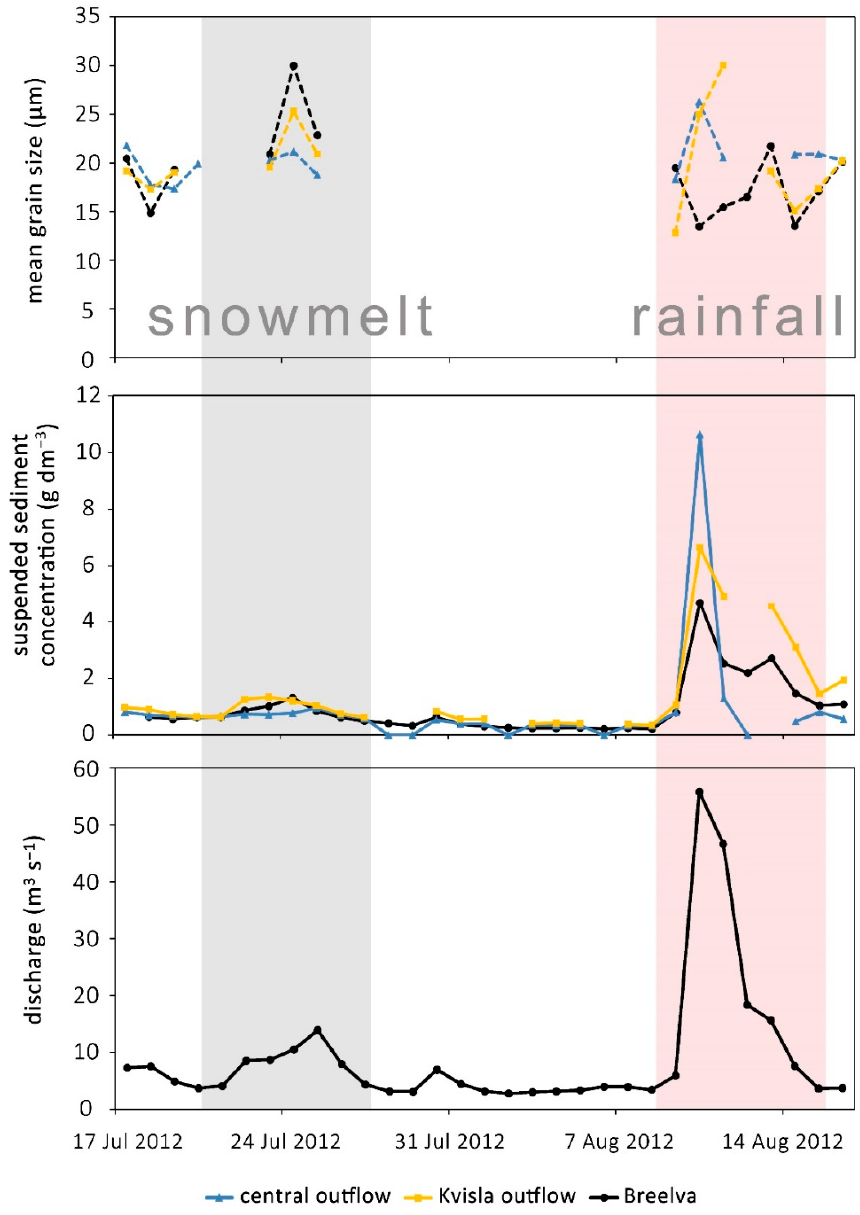
Figure 6. Mean daily grain size, suspended sediment concentration (SSC), and discharge (Q) in the Breelva (hydrometric station—C, Figure 1), central (A, Figure 1), and Kvisla (B, Figure 1) outflows. The snowmelt and rain floods are marked as shaded